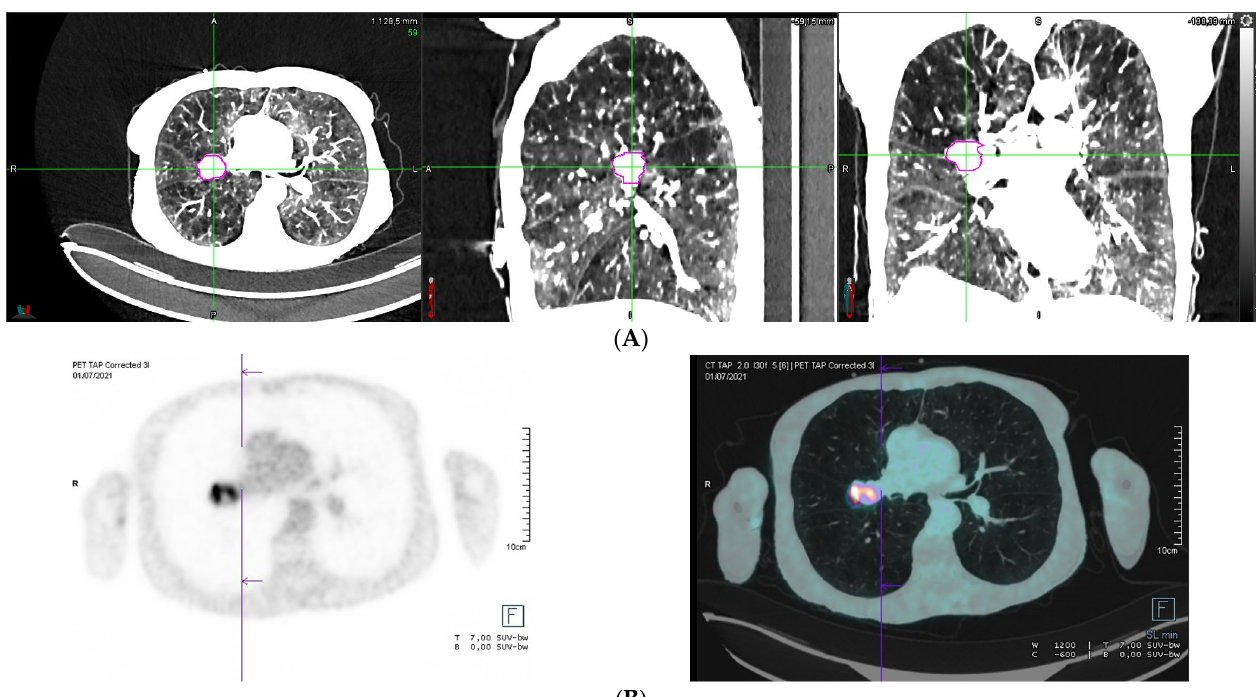
Figure 1. A 73 ‐ year ‐ old female had a very severe chronic obstructive pulmonary disease (COPD) with a forced expiratory volume in one second (FEV1) of 0.23 L (11%). The patient received noninvasive ventilation and permanent oxygenotherapy. She was diagnosed with a lung tumor of the right hilum on chest radiography. On CT, a para ‐ hilar mass of the posterior segment of the right upper lobe was measured to 29 mm × 23 mm in the axial plane ( A ). This mass was highly